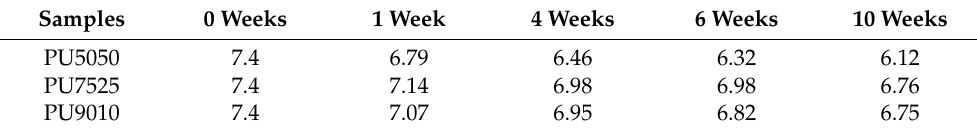
Table 2. pH values of the WPU scaffolds over 10